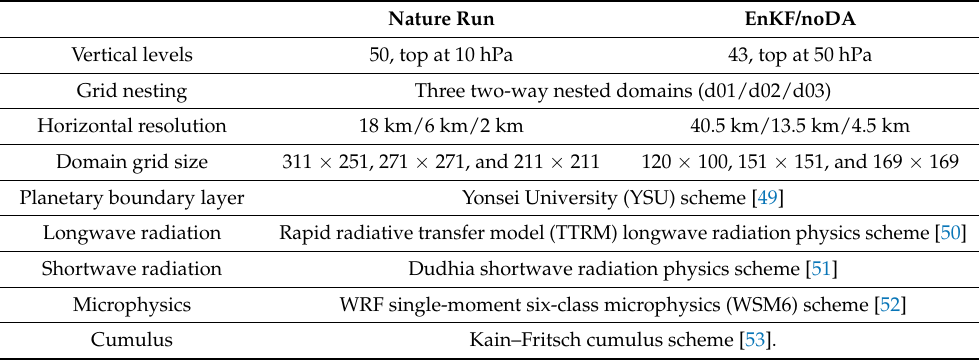
Table 1. Description of model configuration for the nature run, EnKF, and noDA experiment. Nature Run EnKF/noDA Vertical levels 50, top at 10 hPa 43, top at 50 hPa Grid nesting Three two-way nested domains (d01/d02/d03) Horizontal